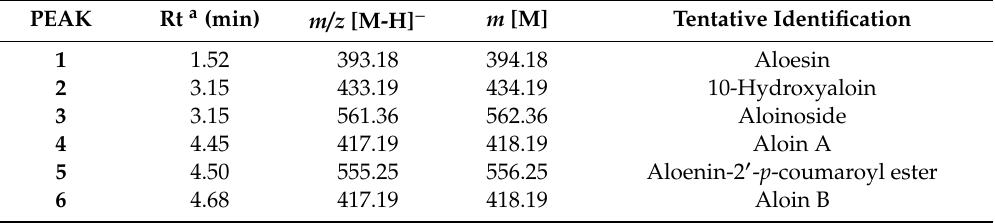
Table 2. Phenolic compounds identified in the aqueous extract of Aloe vera by UPLC-MS. PEAK